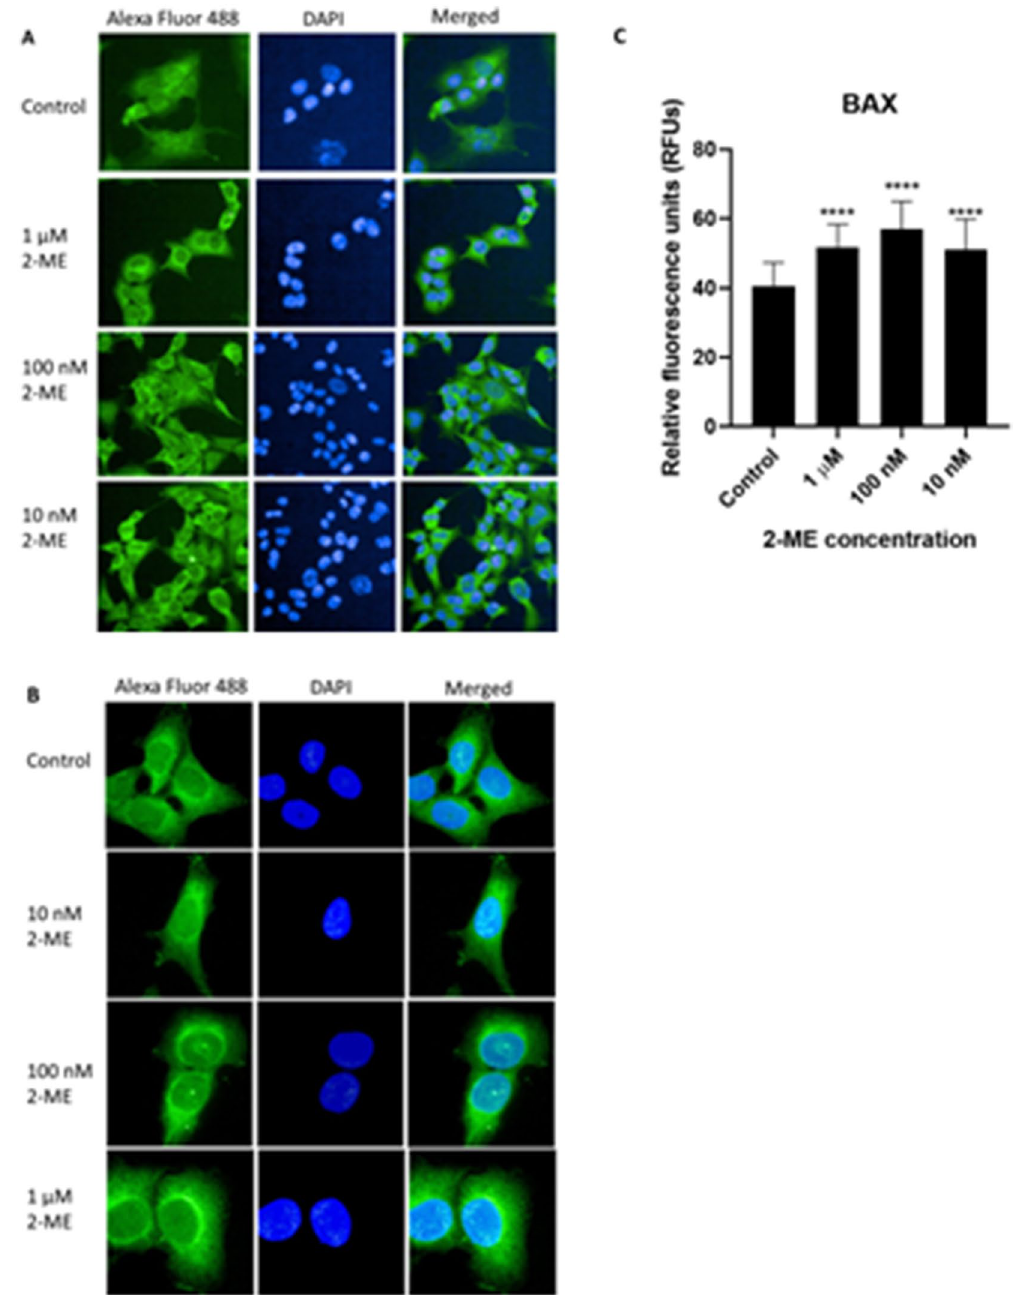
Figure 6. 2-ME increases BAX protein expression in OS 143B cells. Representative immunofluorescence confocal images of OS 143B cells stained with Alexa Fluor 488-labeled anti-BAX antibody (green) and co-stained with nuclear stain (DAPI, blue). OS 143B cells were treated with 10 nM, 100 nM and 1 µM 2-ME for 8 h. Magnifications: ( A ) 200× , ( B ) 1300× Scale bars: ( A ) 100 µm, ( B ) 20 µm. ( C ) The fluorescence intensity of BAX protein after treatment with 2-ME. The images were analyzed and merged using the ImageJ software. The fluorescence intensity was presented in relative fluorescence units (RFUs). Values are the mean ± SD of three independent experiments. **** p < 0.0001 versus control